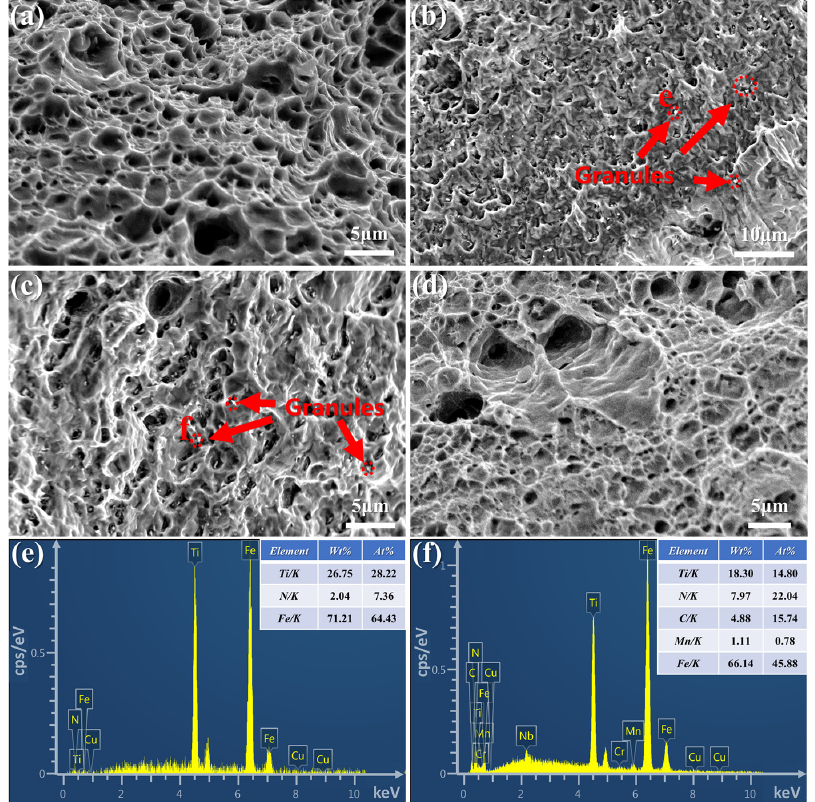
Figure 13. The fracture appearance: ( a ) BM dimple; ( b ) t 8/5 = 6 s dimple magnification; ( c ) enlarged image of the t 8/5 = 8 s dimple; ( d ) enlarged view of the t 8/5 = 18 s dimple; ( e , f ) EDS analysis of particles presented in ( b ) point e and ( c ) point f,